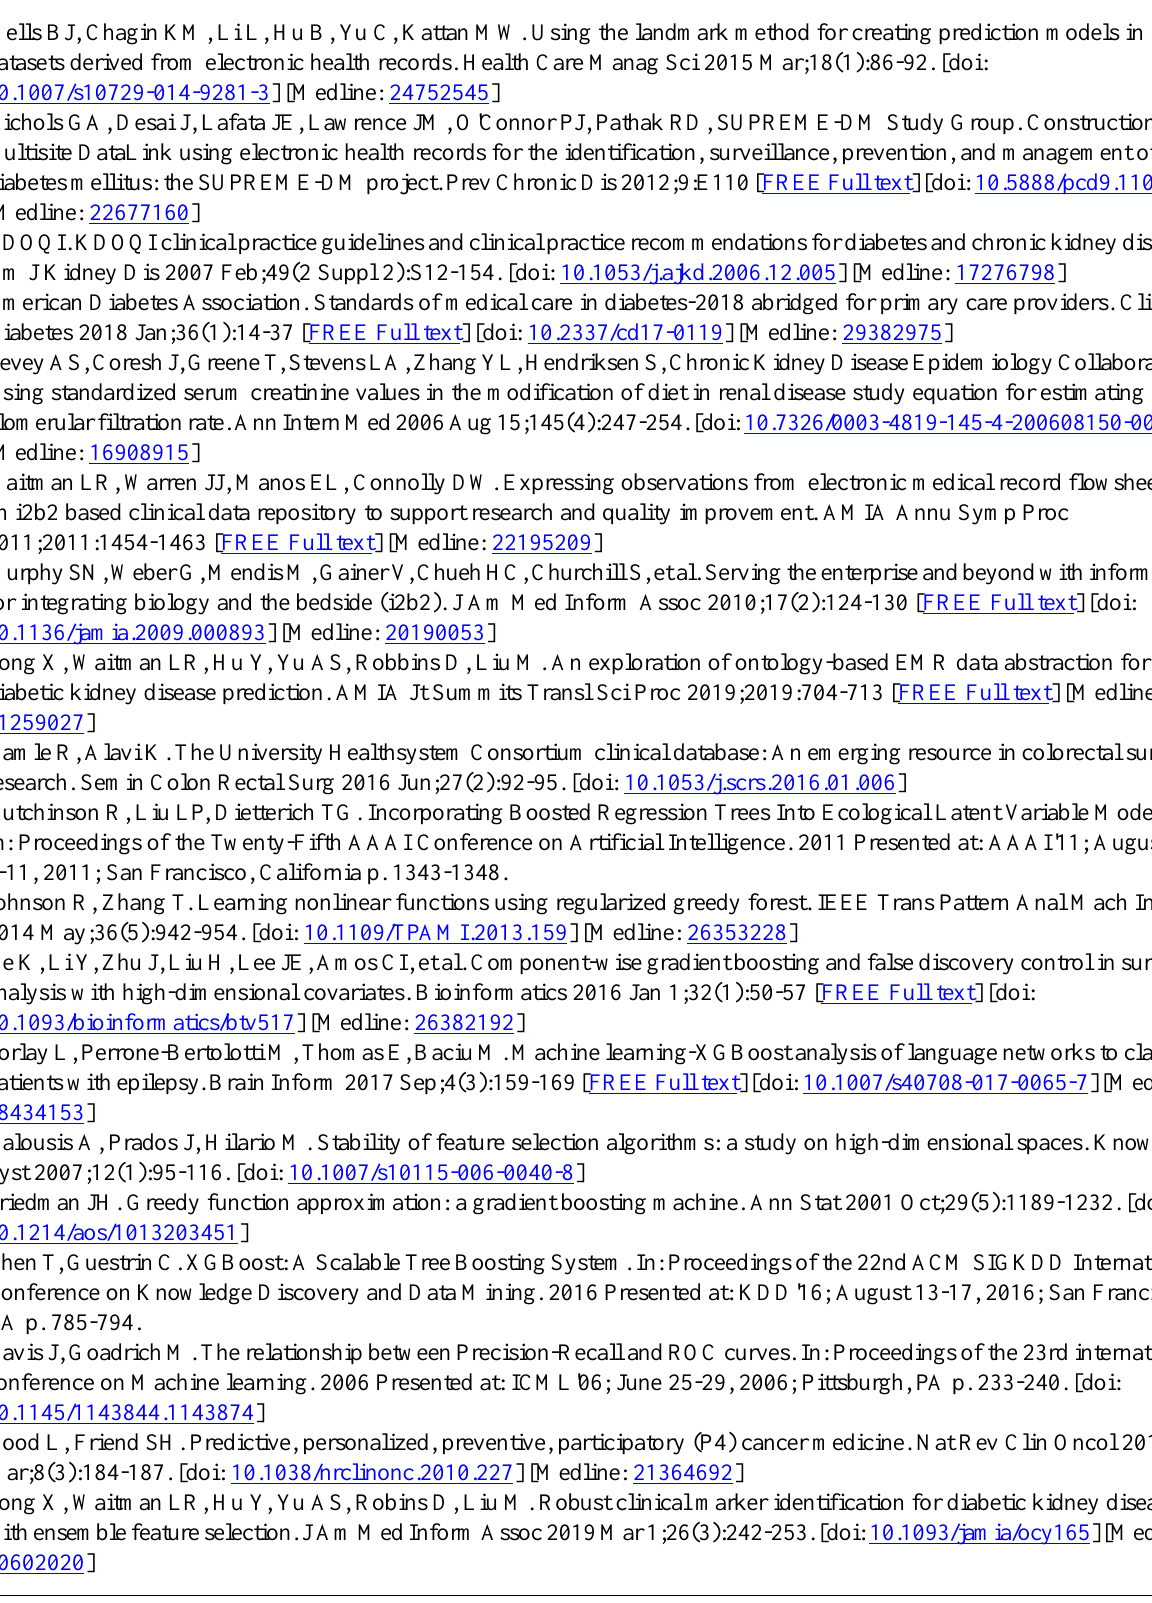
Abbreviations ACR: albumin-to-creatinine ratio AUPRC: area under precision recall curve AUROC: area under receiver operating curve CKD: chronic kidney disease